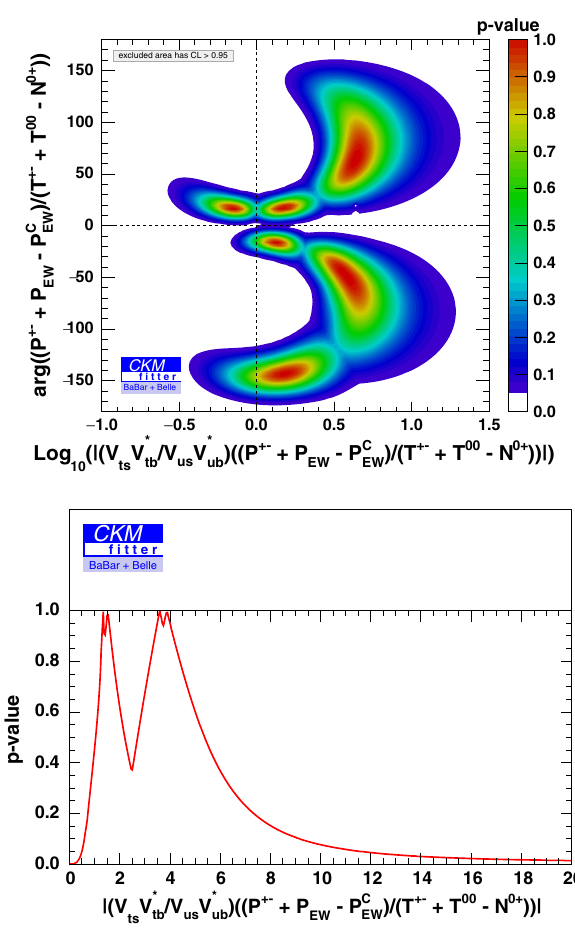
Fig. 6 Top two-dimensional constraint on the modulus and phase of )/( T +− + T 00 − N 0 + ) ratio. For conve- the ( P +− + P EW − P C EW C nience, the modulus is multiplied by the ratio of CKM factors appear- ing in the tree and penguin contributions to the B + → K (cid:7) + π 0 decay amplitude. Bottom one-dimensional constraint on the modulus of the ( P +− + P − P C )/( T +− + T 00 − N 0 + ) ratio EW EW C